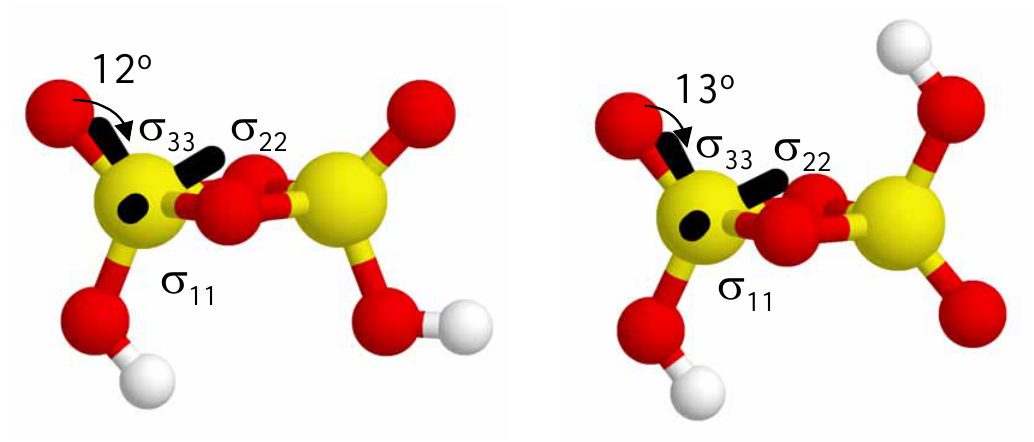
Figure 6. The relative orientation of the 31 P CSA tensor in the cis ( + + ) and the trans ( + − ) configurations in the 2-P-membered cyclic phosphate clusters. The orientation of the tensor is nearly principal axis being ~12 o from the terminal P=O bond. identical in both configurations, with the σ 33